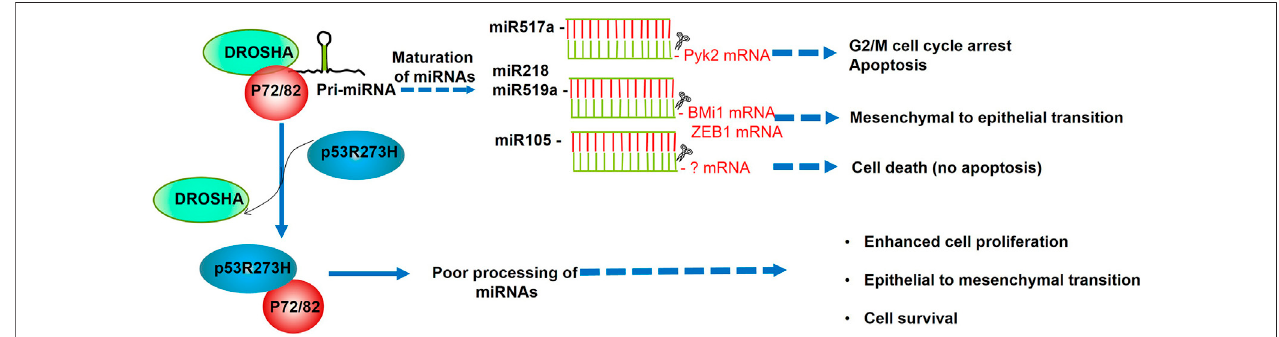
FIGURE 2 | p53R273H promotes cell survival, proliferation, and epithelial to mesenchymal transition through sequestering p72/82. The association of p72/82, members of the DEAD-box family of RNA helicases, with DROSHA, is necessary to achieve a fi ne-tune processing of speci fi c subsets of miRNAs. As p53R273H sequesters RNA helicases p72/82 from the microprocessor complex, this interferes with the maturation of miR517a, miR218, miR519a, and miR105. According to the biological processes regulated by these miRNAs, their downregulation provokes higher cell proliferation, cell survival, and EMT promotion.